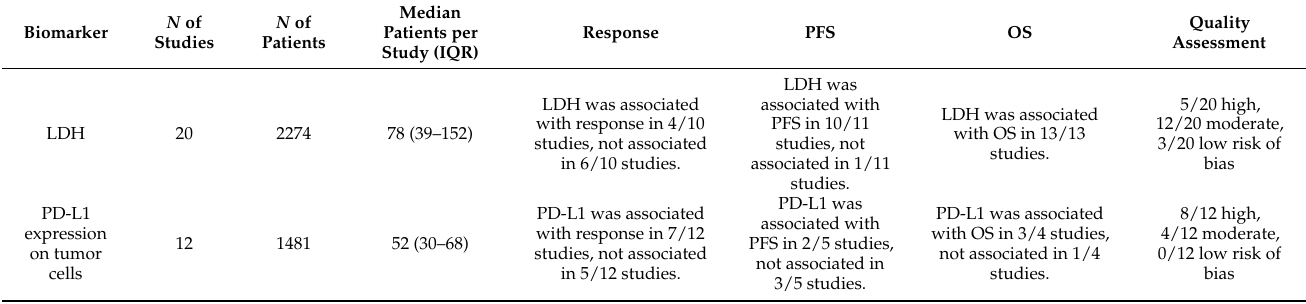
Table 2. Summary of most important biomarkers that were studied for anti-PD-1 therapy and assessed risk of bias per